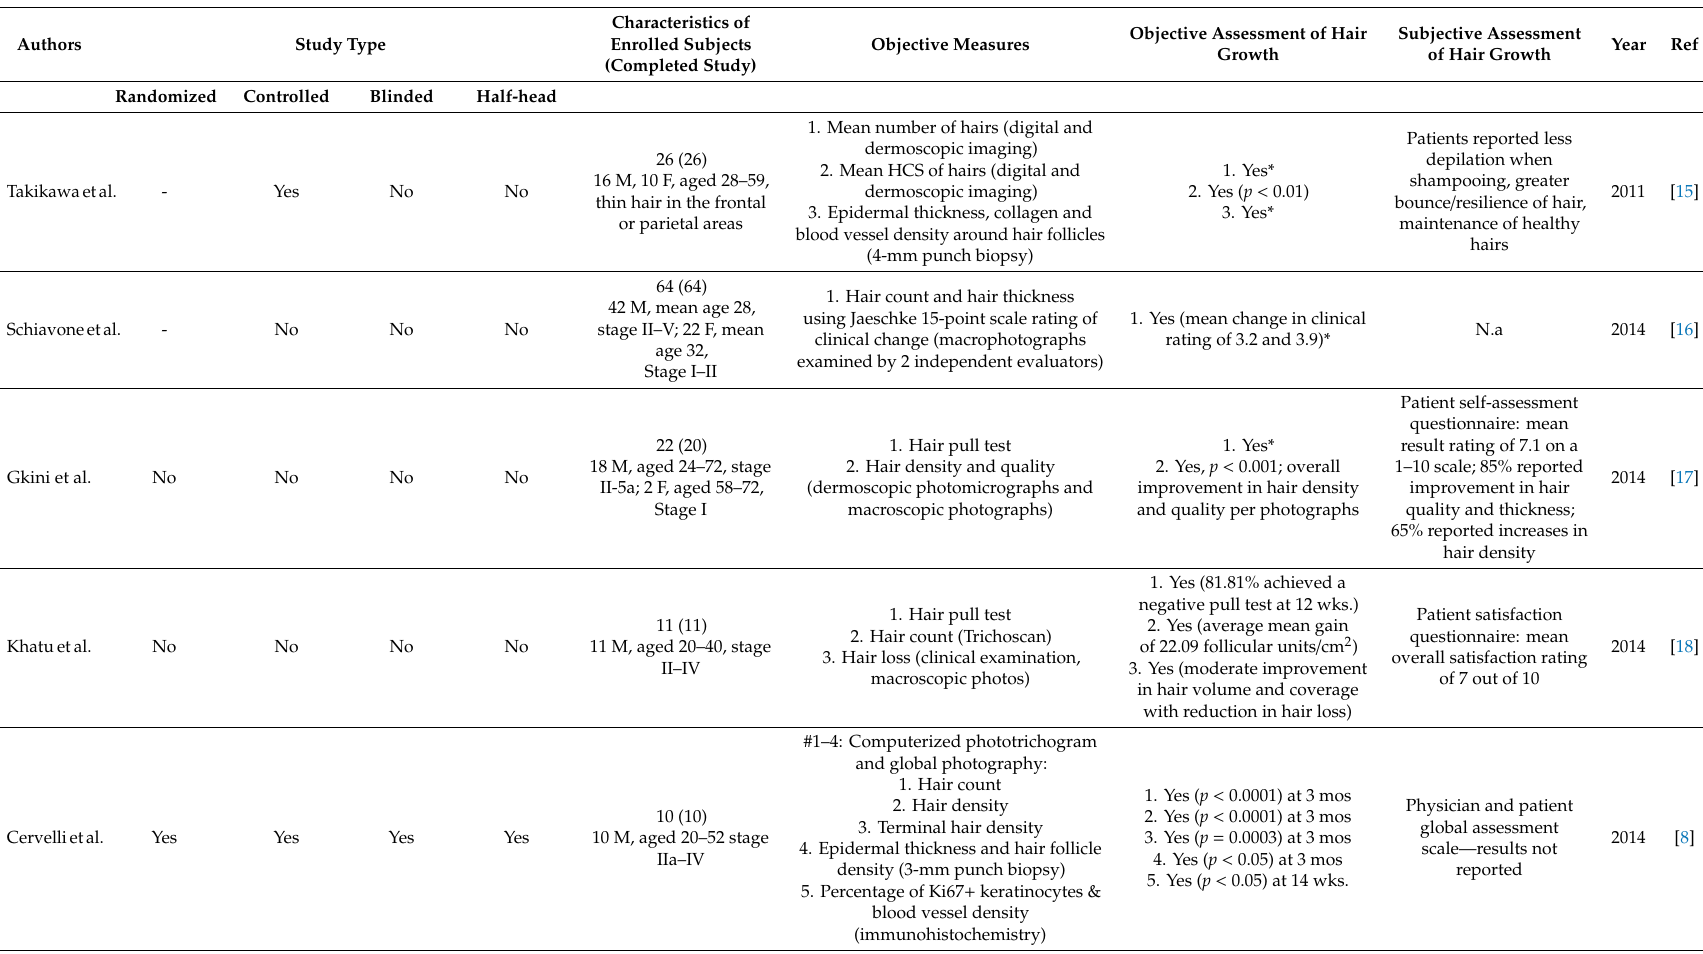
Table 1. The study design and results of the included studies. Abbreviations: M, male; F, female; wks, weeks; mos, months. * p value not